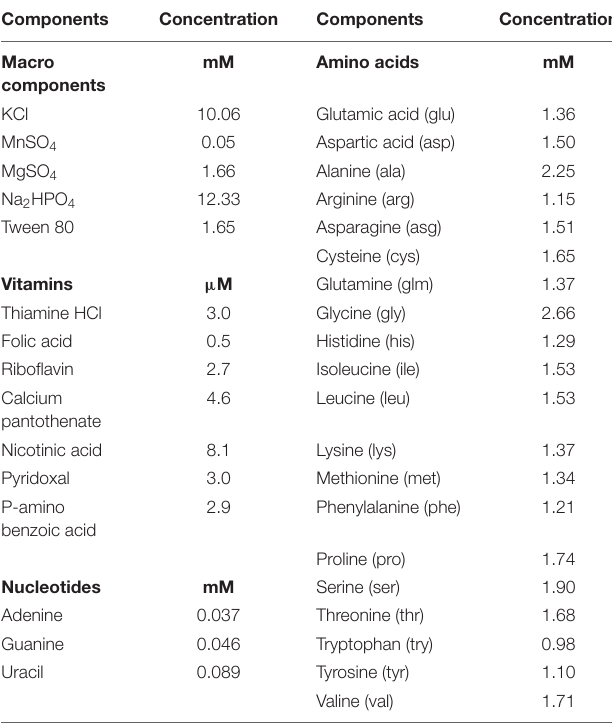
TABLE 1 | Defined medium (DM)